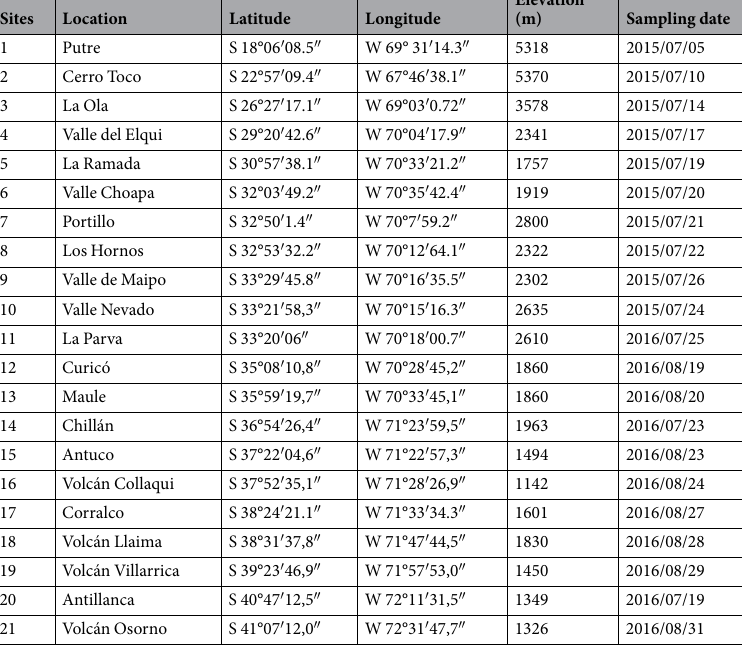
Table 1. Sampling